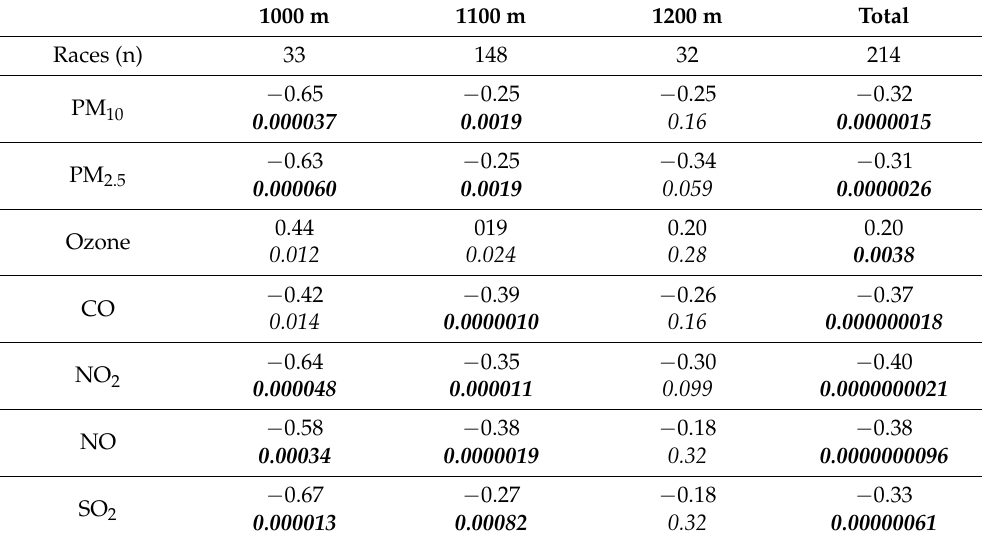
Table 2. Spearman’s Rho (above) and p -values (in italics below) calculated between the winning horse’s speed and the mean values of the pollutant concentration during the six hours prior to the race in the “Handicap” category for the distances of 1000, 1100, 1200 m and for all the races together. The n for O 3 were 32, 138, 30 respectively, while for the total races it was 200. Significant p -values using the Bonferroni adjustment are shown in bold